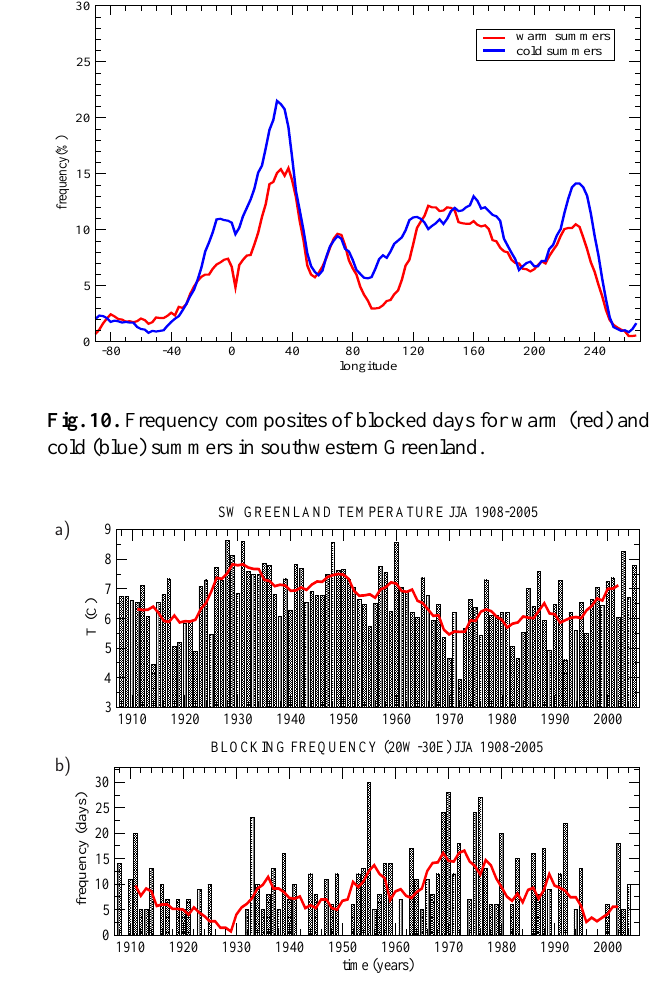
Fig. 11. (a) Southwestern Greenland temperature index during sum- mer (Vinther et al., 2006) (bar) and its decadal variation (7-year run- ning mean) (red) for the period 1908 to 2005. (b) Blocking index (bar) and its decadal variations (7-year running mean) (red) for the same